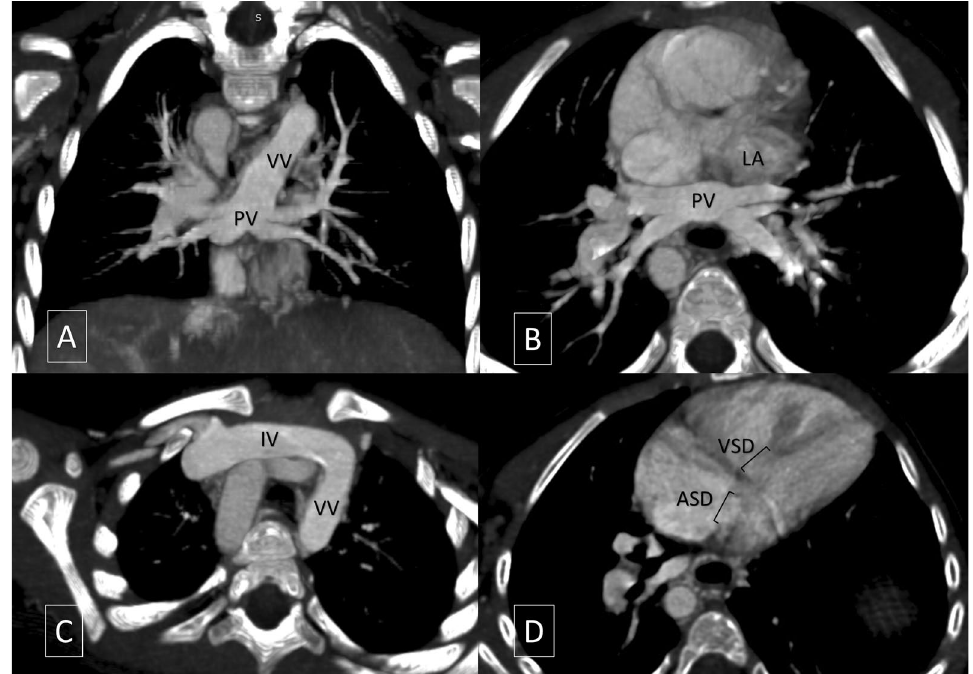
Fig. 1 Axial and coronal section of CT angiography of the cardiac vasculature. All four pulmonary veins (PVs) are in confluence behind the small left atrium (LA), and their confluence converges to an ascending lateral large vertical vein (VV) which drains into innominate vein (IV) ( A – C ). The entrance of PV into LA is absent. All the finding favors to supracardiac TAPVC. Large ostium secundum atrial septal defect (ASD) and ventricular septal defect (VSD) were identified ( D